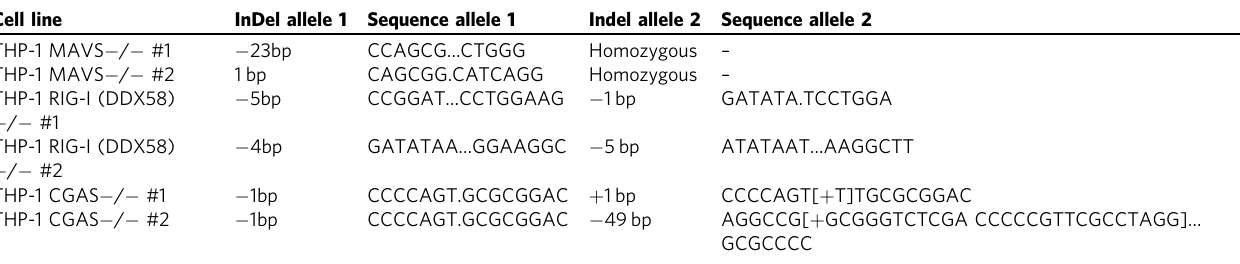
Table 1 Sequence and insertion-deletion length of THP-1 knock-out genotypes for RIG-I, cGAS, and